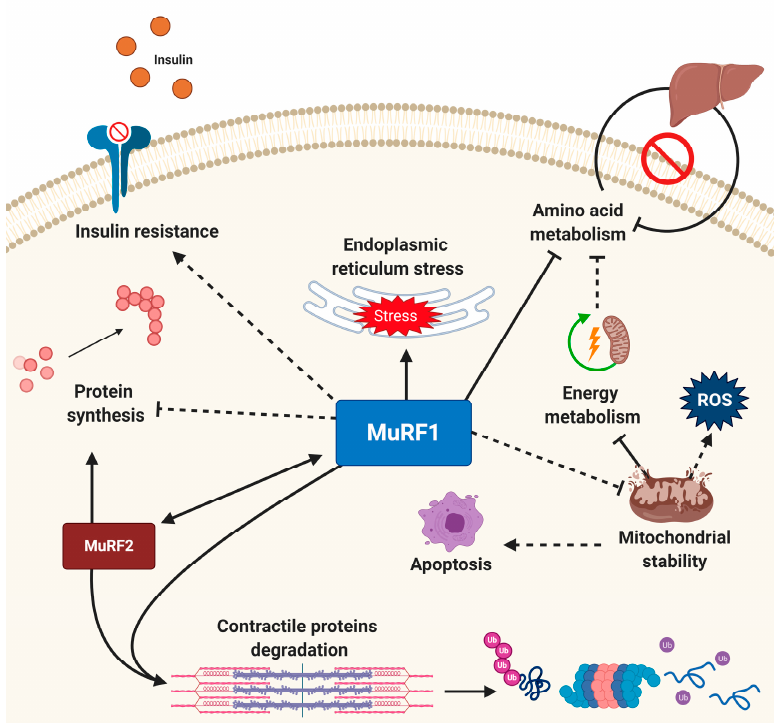
Figure 3. MuRF1 as a potential central node for regulating cellular homeostasis. While MuRF1 is known to play a primary role in sarcomeric protein degradation, recent evidence indicates it may govern multiple cellular processes that include mitochondrial health, apoptosis, insulin resistance, endoplasmic reticulum stress response, amino acids, and carbohydrate metabolism. MuRF1 also works in synergy with MuRF2 to mediate muscle wasting. Solid lines indicate mechanisms with strong supporting evidence for direct effects MuRF1 effects, with recently emerging mechanisms that require further validation represented by dotted lines (direct or indirect). See the main text for full details.